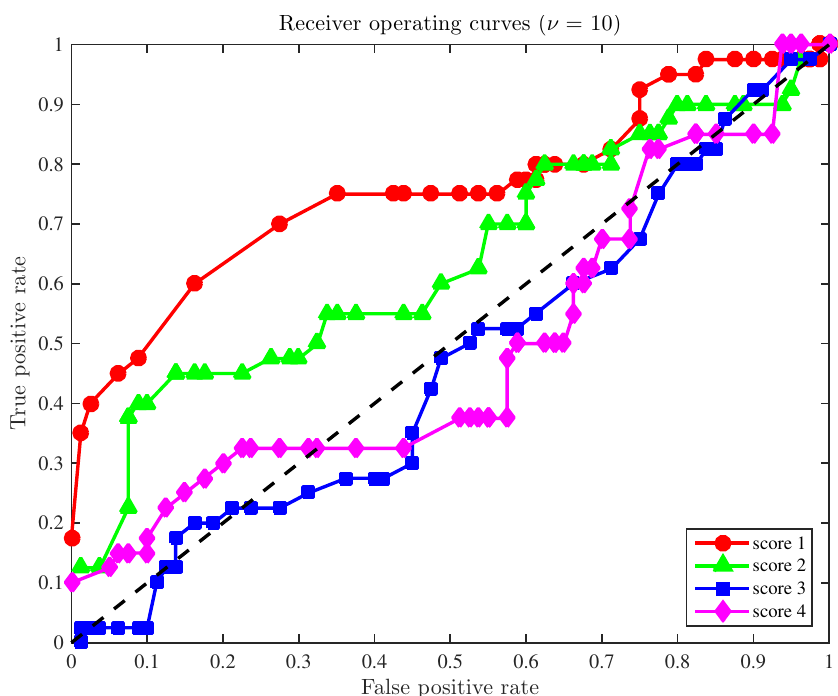
Figure 6. The ROCs for the four scores when the size of the samples to diagnose is ν = 10 and all the sensors are